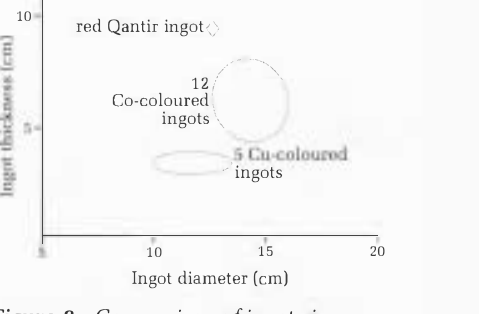
Figure 8 Comparison of ingot sizes between the blue glass ingots from the Uluburun shipwreck, five of which are coloured with copper (Cu-coloured) and twelve with cobalt (Go-coloured}, and the red Qantir